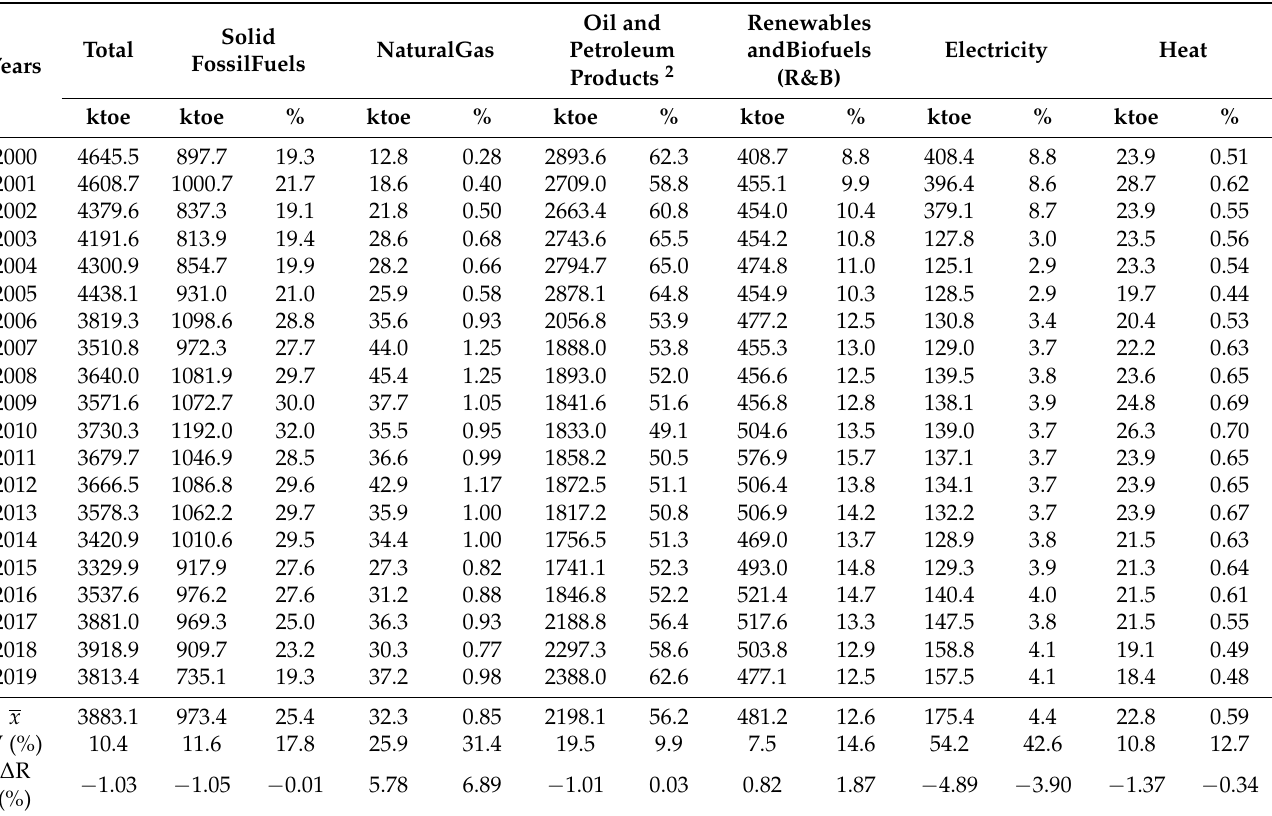
Table 1. Energy consumption and structure in Polish agriculture in 2000–2019 (ktoe—thousand tons of oil equivalent) 1